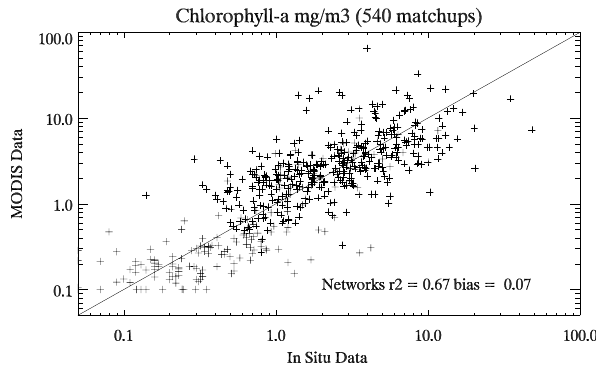
Fig. 2. MODIS-derived chlorophyll versus in-situ observations at the selected